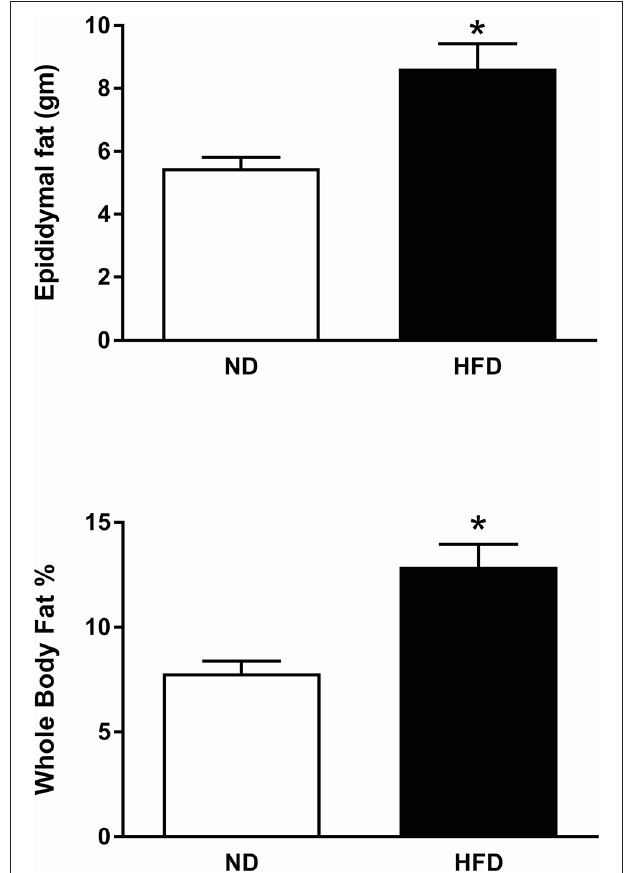
FIGURE 18 | Effect of high fat diet (HFD) and normal diet (ND) in the epididymal fat (ND, n = 15 HFD, n = 15) and in the whole body fat percentage (ND, n = 10; HFD, n = 12). * P < 0.001 compared with